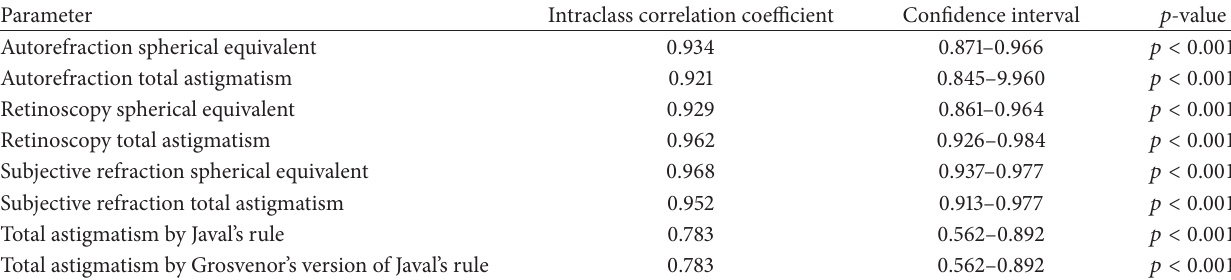
Table 1: Intraclass correlation between right and left eyes for various parameters.